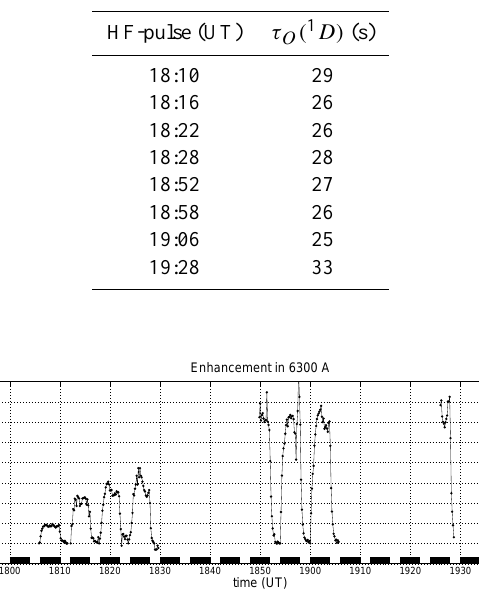
Table 1. Estimates of O( 1 D) effective lifetime from the initial de- cay of the enhancement in 6300 ˚A emission as observed by DASI.